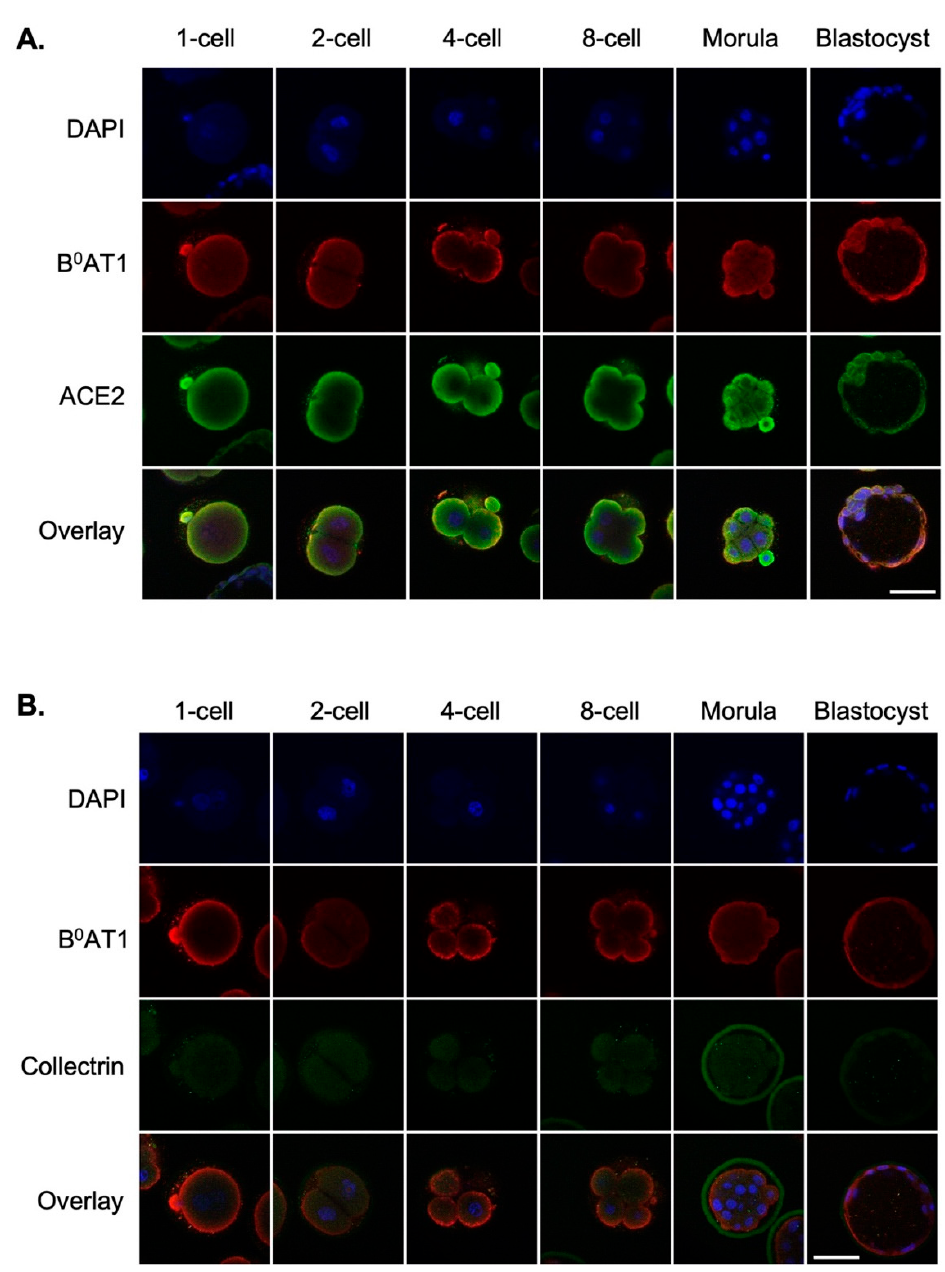
Figure 2. ACE2 colocalises with B 0 AT1 in the mouse preimplantation embryo. Embryos were freshly isolated from QS mice at 1-, 2-, 4-, and 8-cell, morula and blastocyst stages, fixed and immunostained for B 0 AT1 (red) and ( A ) ACE2 (green), or ( B ) collectrin (green) . Nuclei were counterstained with DAPI (blue). Fluorescent images were captured by confocal microscopy using a 40 × objective. No staining was observed when a pre-immune IgY or IgG equivalent was used as a negative control for the primary antibodies (not shown). Scale bar = 50 μ m for all images.